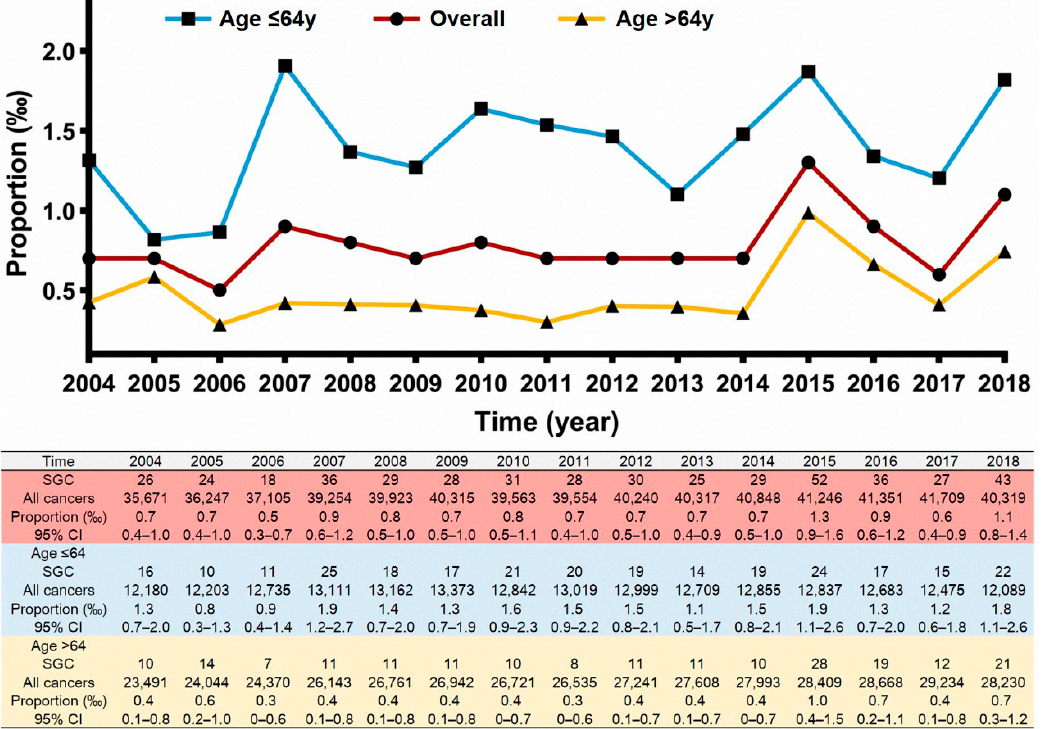
Figure 2. The crude incidence rate of salivary gland-type carcinoma over time in the 593,662 lung cancer patients. cancer